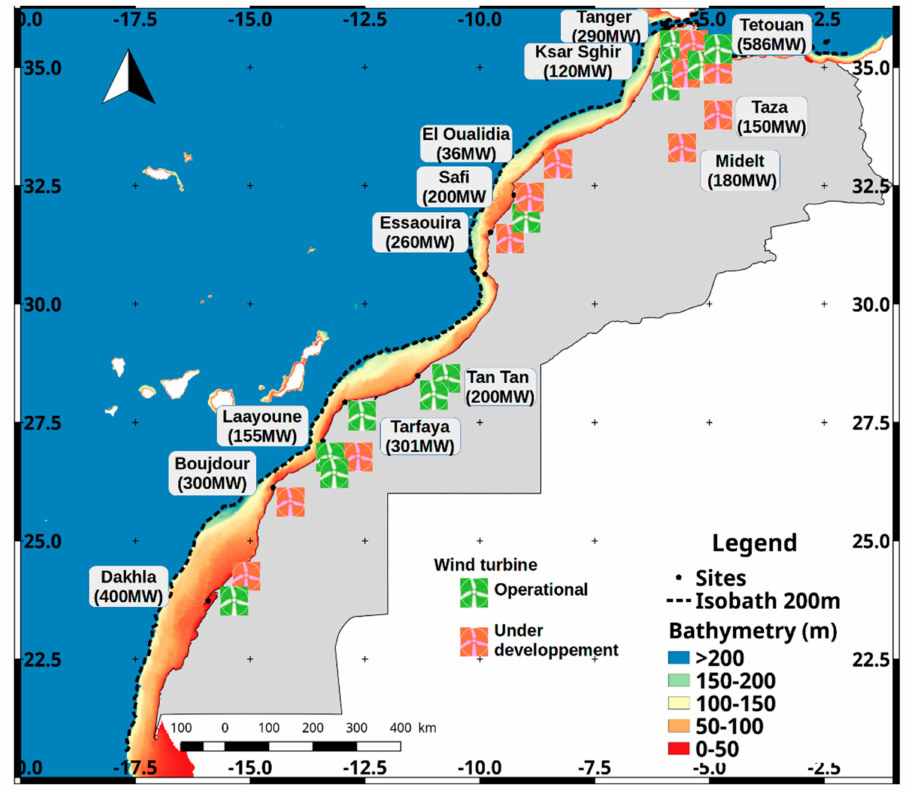
Figure 1. Study area showing the major sampled sites superimposed on the bathymetry of the Moroccan continental margin derived from the gridded chart of the European Marine Observation and Data Network (EMODNET) with the dashed isobath line of 200 m highlighting the width of the continental shelf (https://www.emodnet-bathymetry.eu/data-products) [8]. Also, the energy map emphasizes the location of present and future wind farms projects by